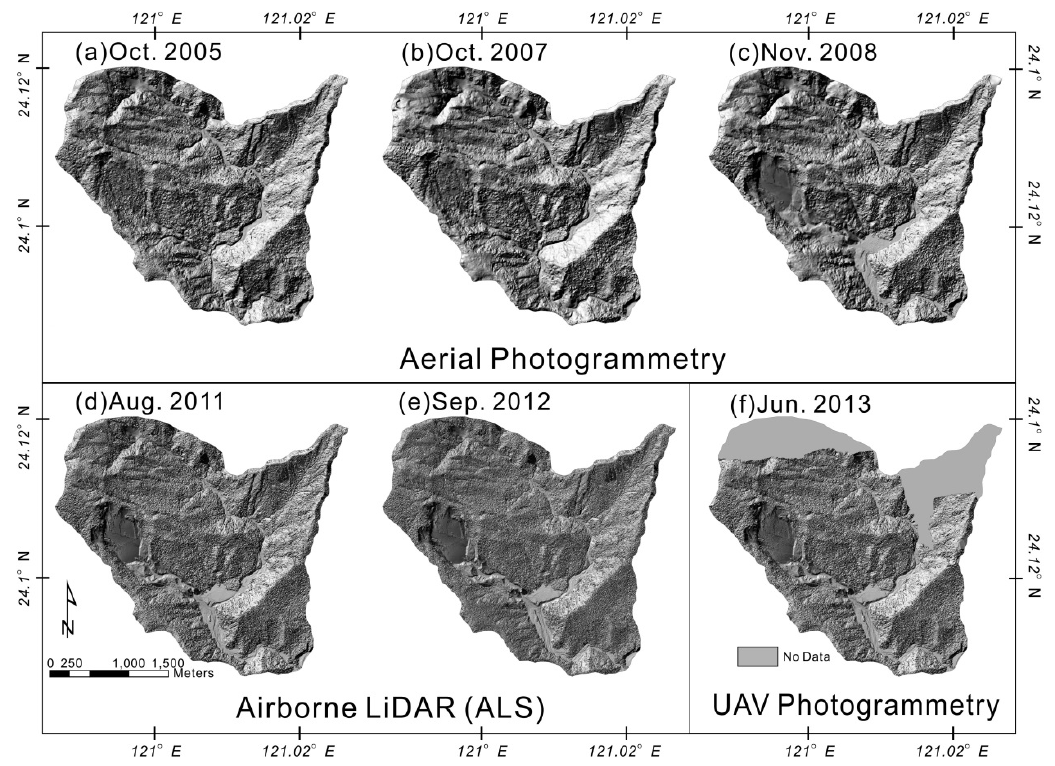
Figure 5. Digital Surface Model (DSM) images generated from six periods. ( a – c ) are the traditional aerial photogrammetry images; ( d , e ) were taken by the ALS technique; and ( f ) obtained through UAV aerial photogrammetry. The uniform grey areas shown in the images represent lack of information due to clouds.